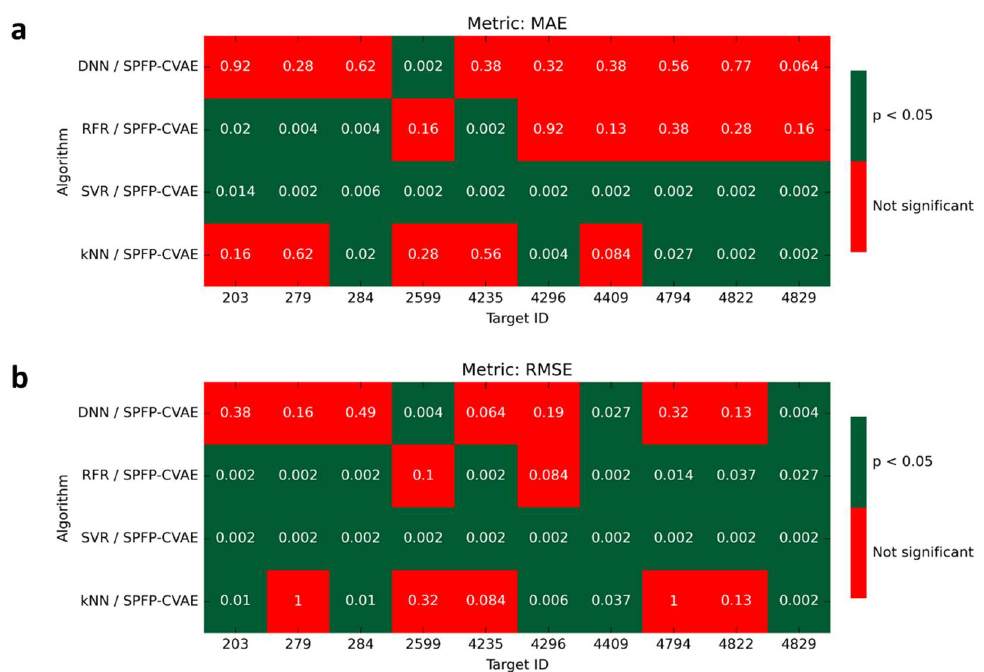
Figure 7. Statistical significance assessment. Statistical significant (Wilcoxon signed-rank) tests based on ( a ) MAE and ( b ) RMSE values were carried out for the performance differences observed between SPFP–CVAE and all other ML models (kNN, SVR, RFR, and DNN). Red cells indicate p -values above α = 0.05 (no statistical significance) and green cells p -values below α = 0.05 (statistical significance).